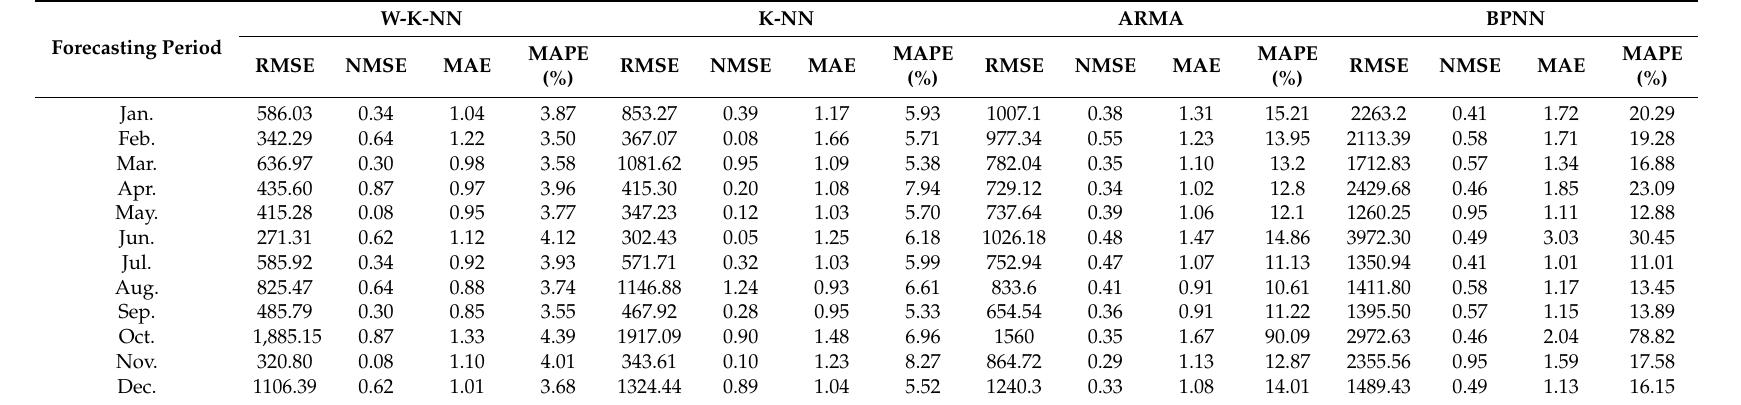
Table 5. Comparison of four forecasting models for the small sample (RMSE, NMSE, MAE and MAPE). Unit: MW.